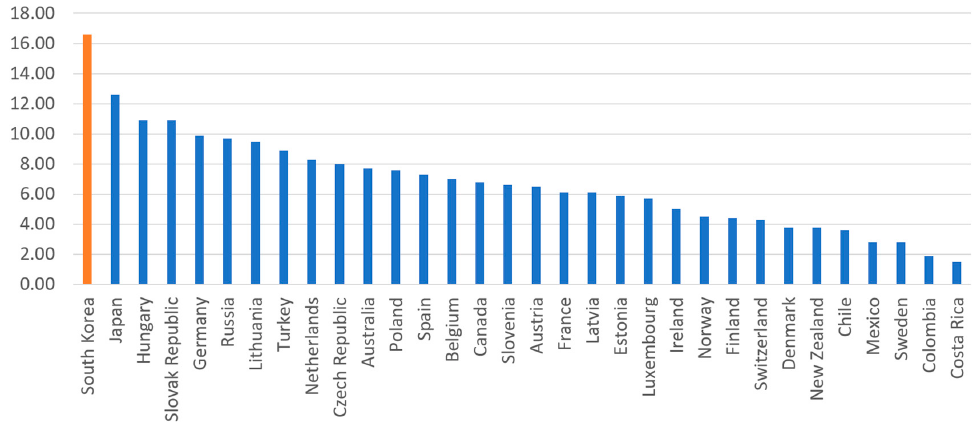
Figure 5. Number of consultations patients have with doctors in a year. Source: OECD (Publicly available data. No copyright issue).